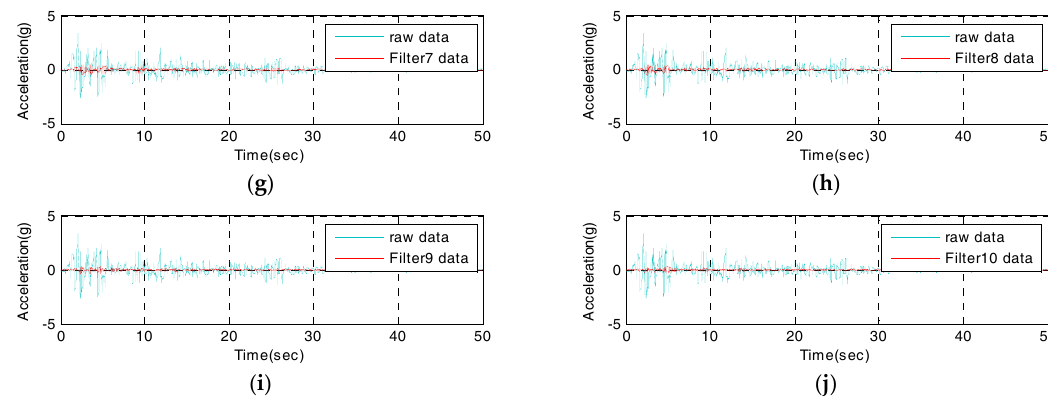
Figure 10. Time domain response of optimal condition AFB: ( a ) filter 1 data; ( b ) filter 2 data; ( c ) filter 3 data; ( d ) filter 4 data; ( e ) filter 5 data; ( f ) filter 6 data; ( g ) filter 7 data; ( h ) filter 8 data; ( i ) filter 9 data; ( j ) filter 10 data.